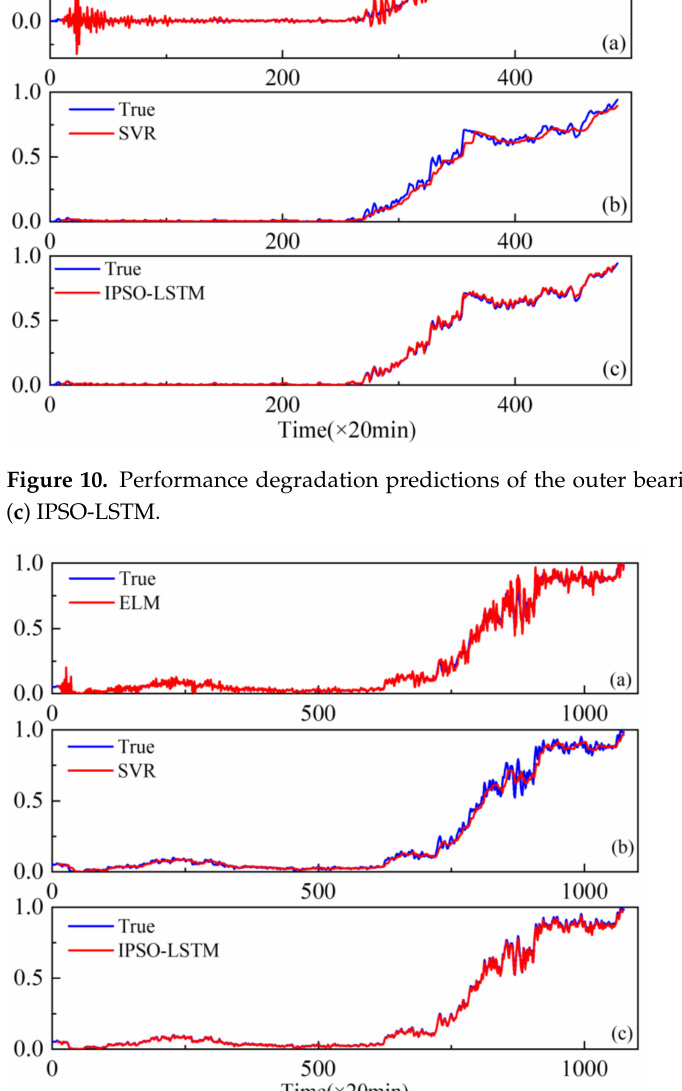
Figure 11. Performance degradation predictions of roller bearings for the: ( a ) ELM; ( b ) SVR; ( c )